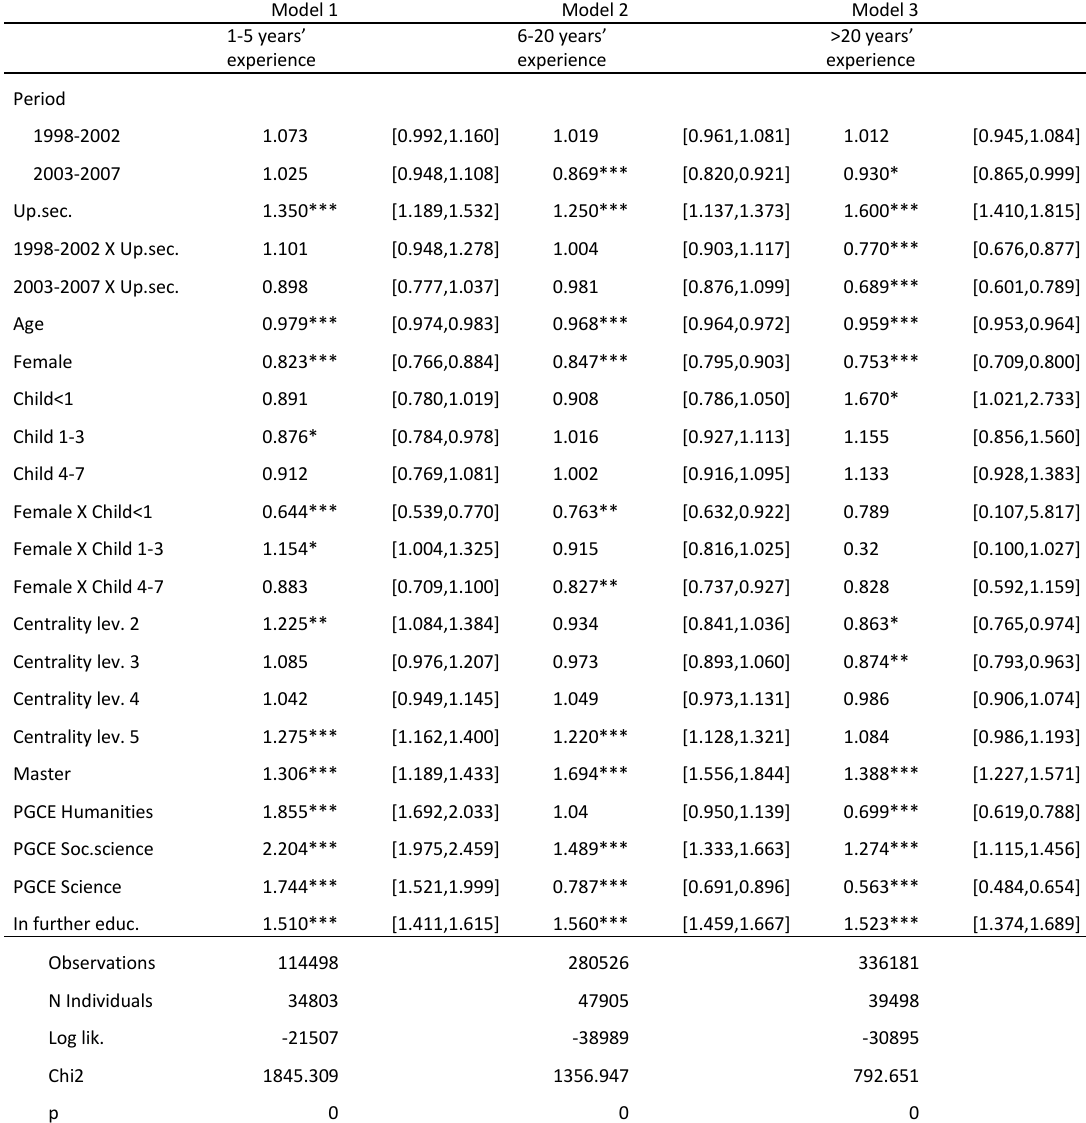
Table A2 Employment-exit. Poisson regression with cluster robust SE, exponentiated coeffi- cients. Dependent variable: Not employed in same school level. Reference is first time-period (1992-1997), GTE graduate, employed in primary/lower secondary, male, no children<8, low centrality municipality, not in further education, no mas- ter’s degree. Separate models for teachers in different